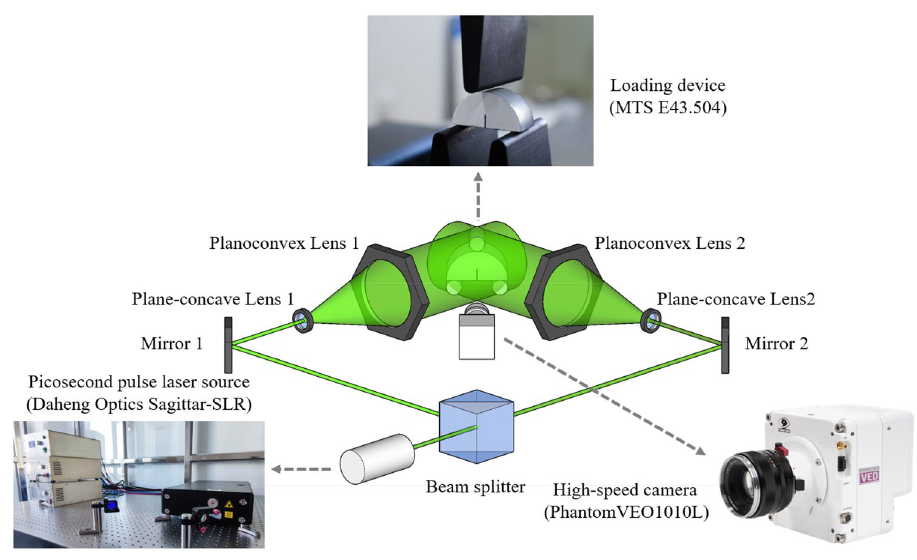
Figure 3. Experimental system